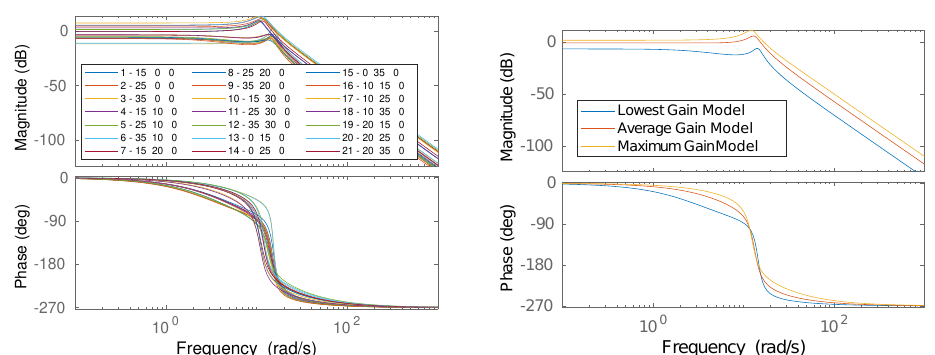
Figure 5. Frequency response of the models obtained using RLS, showing all the identification experiments ( left ) and the three most representative examples: Lowest, Average and Maximum Gains ( right ).